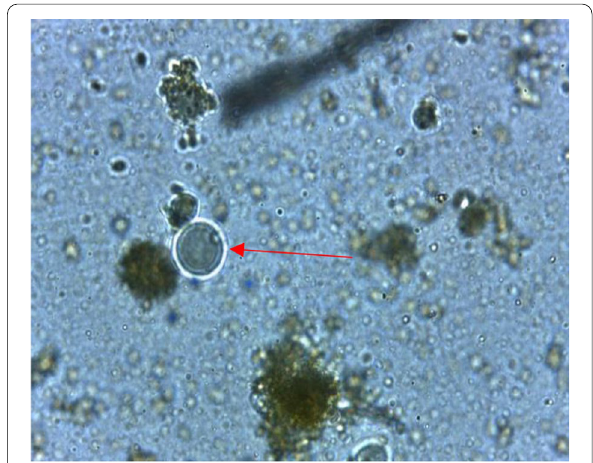
Fig. 2 Egg of Ascaris sp